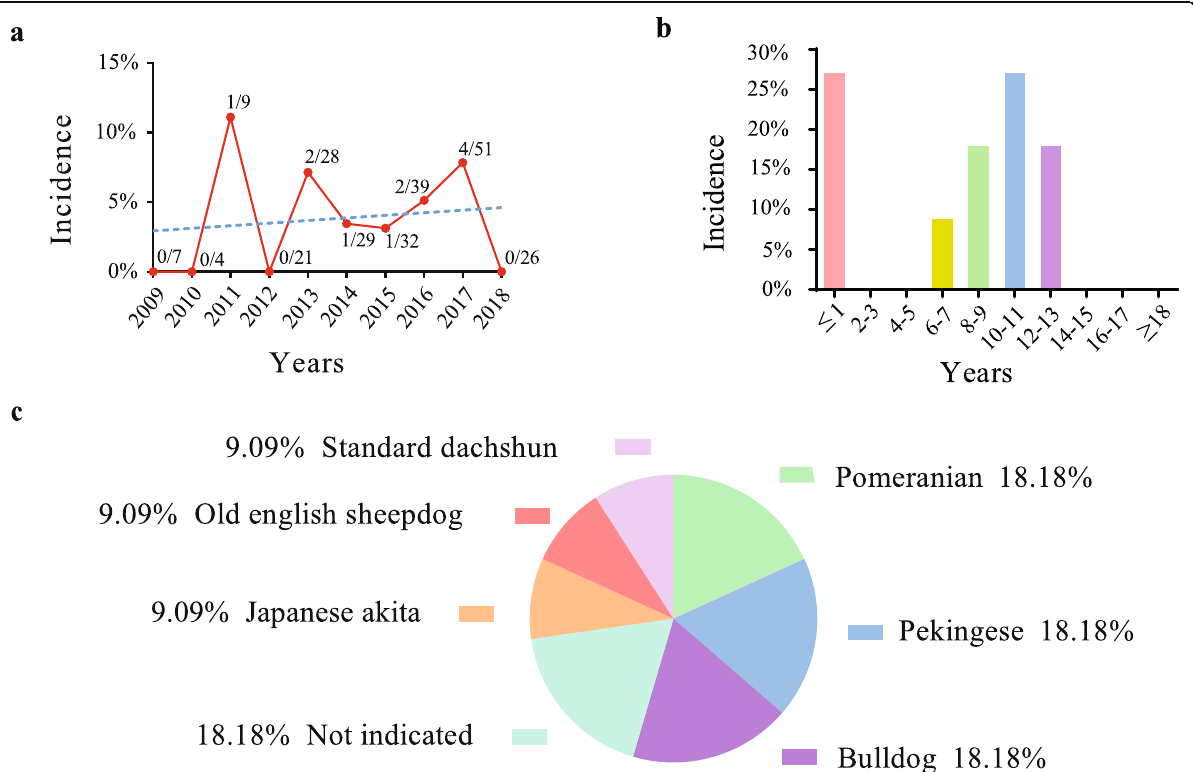
Fig. 5 Correlation of age and breed with ocular tumors in pet dogs. a Dynamic changes of ocular tumors incidence in pet dogs from 2009 to 2018. The dotted line represents linear regression. b Incidence of ocular tumors in pet dogs at different ages. c Proportion of different breeds with ocular